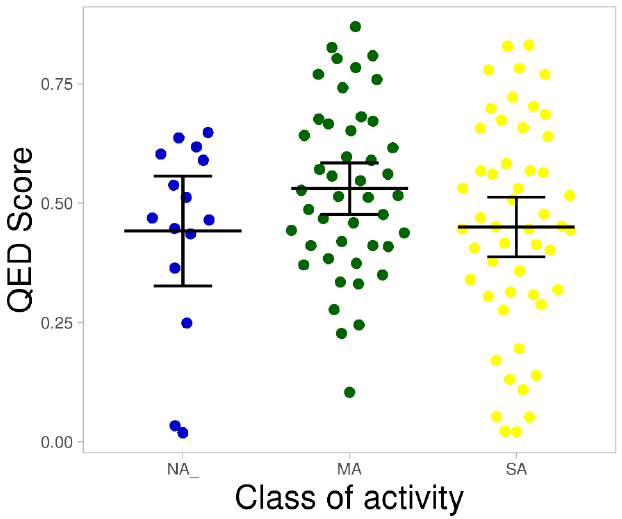
Figure 13. Distribution of the categories of AMNPs based on their desirability score. The markers with colors, red, green, and blue, represent MA, SA, and NA categories, respectively. The line that divides the boxes represents the median of the distributions. The black bars indicate a 95% confidence interval.